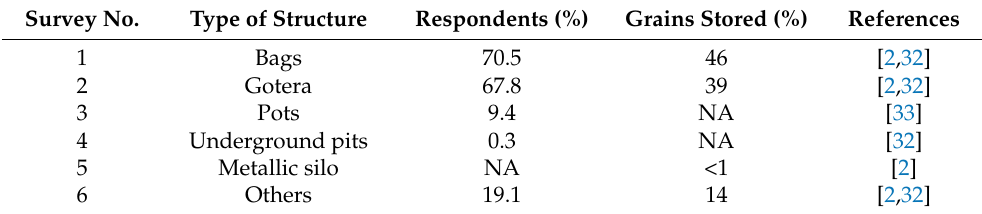
Table 3. Post-harvest storage methods in Ethiopia expressed as % of the total number of storage methods used for each cereal type.